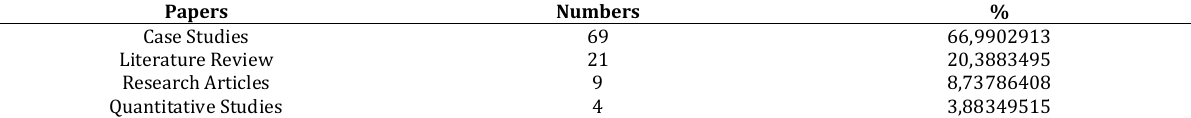
Table 2: Distribution of research papers Papers